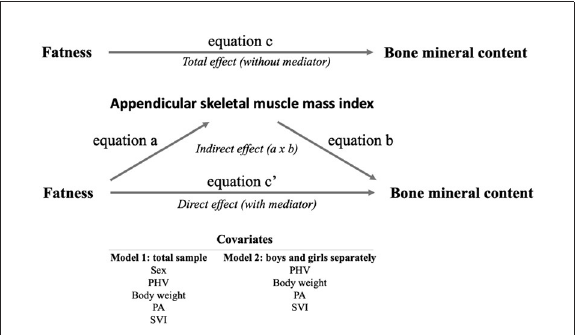
FIGURE1 Mediation analysis approach. PHV, peak high velocity; PA, physical activity; SVI, school vulnerability index.